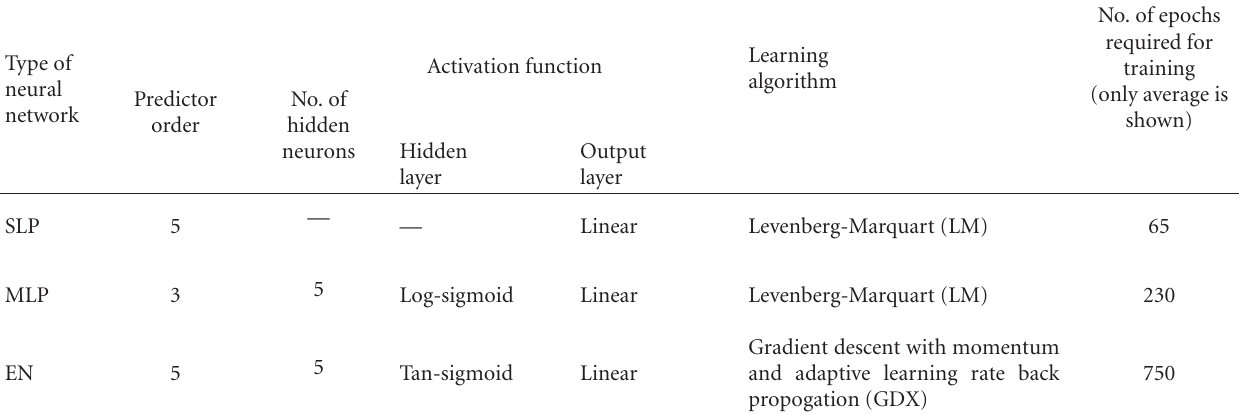
Table 1: Optimal configuration of the network.